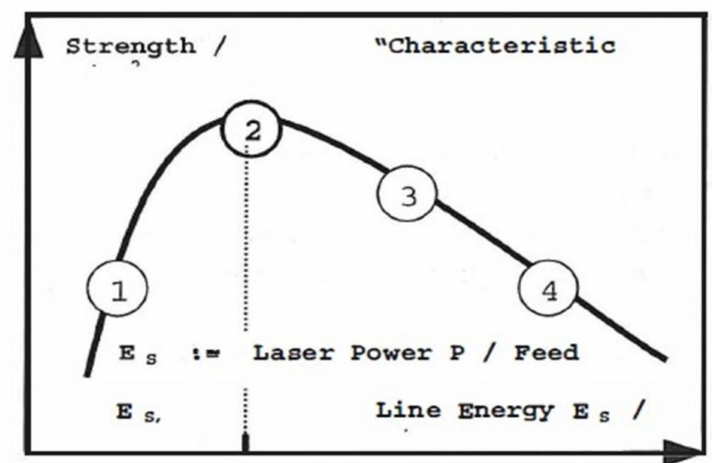
Figure 11. Characteristic curve—strength Vs line energy: 1. just light adhesion—no good welding; 2. optimal welding adjustment; 3. optimal adjustment left—bad welding; 4. decomposition—bad welding [176]. Reproduced from [176], with the permission of the Laser Institute of